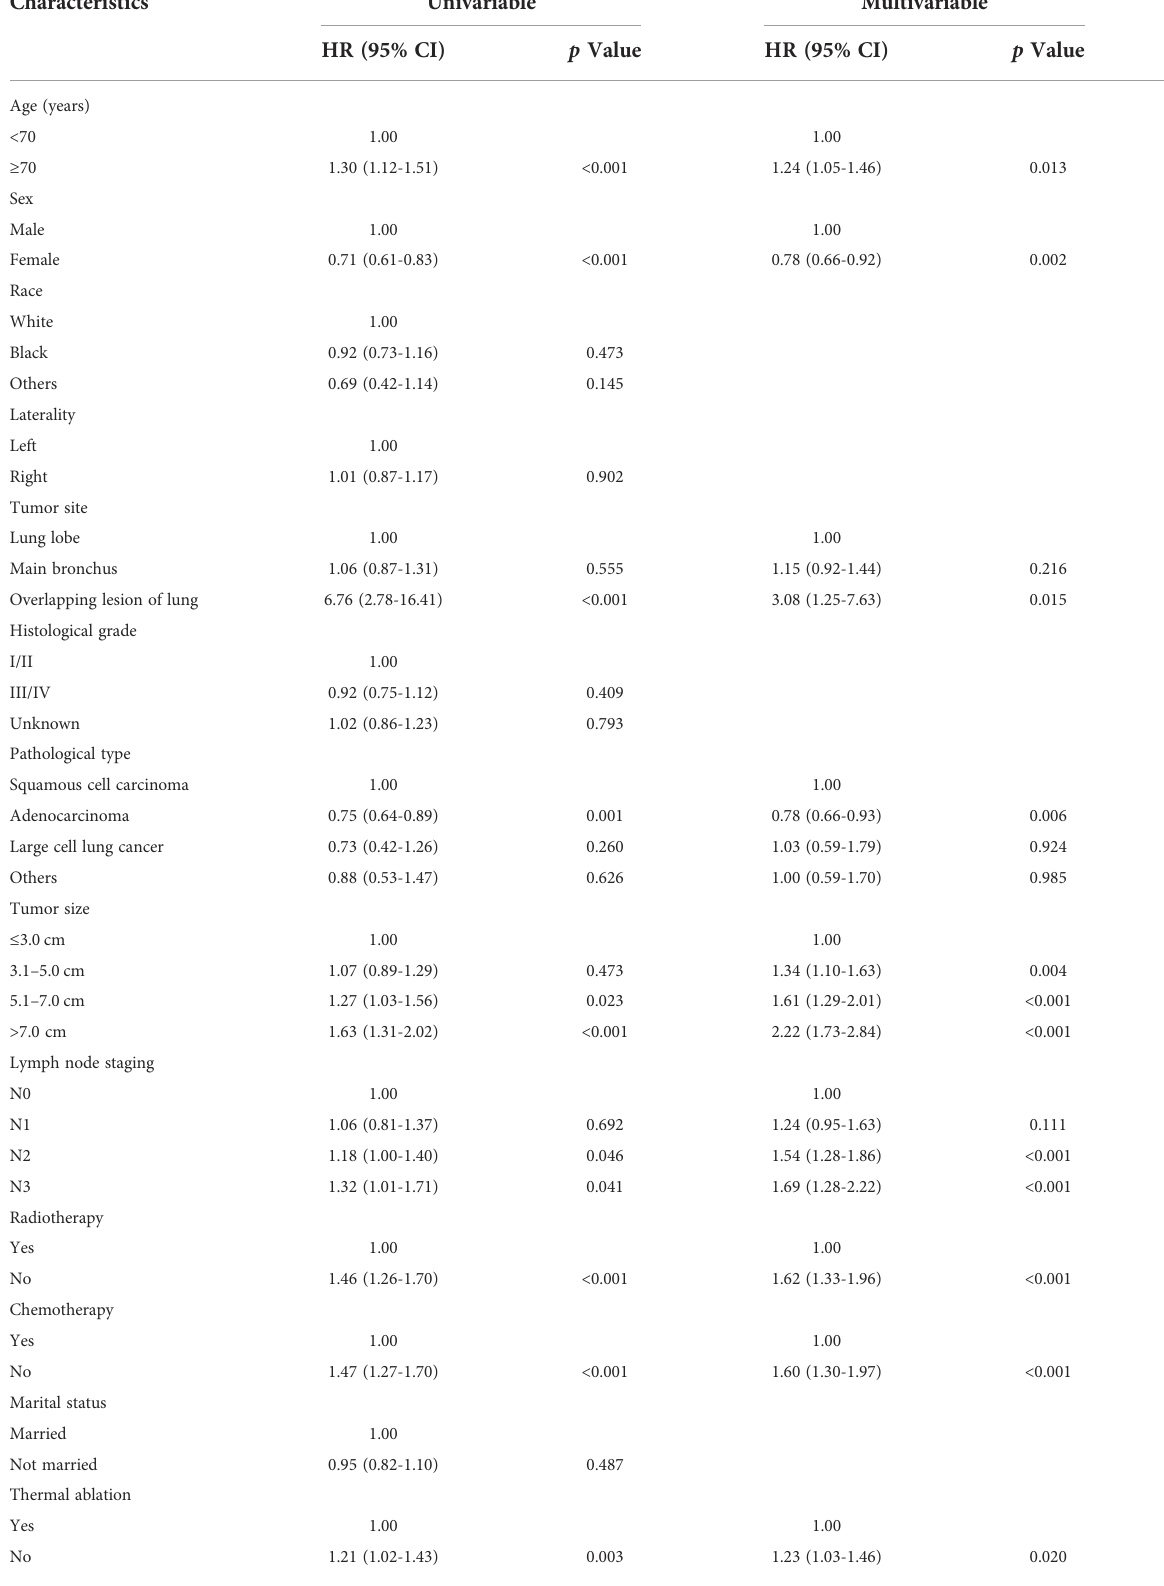
TABLE 3 Univariate and multivariate analyses of CSS after